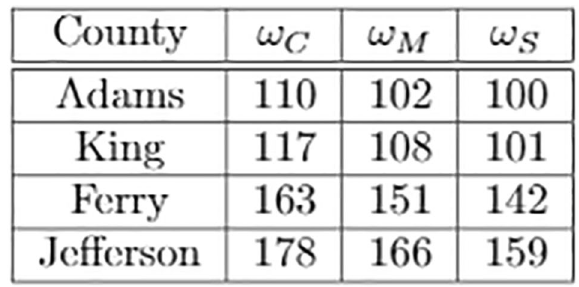
Figure 19. Number of days until herd immunity is